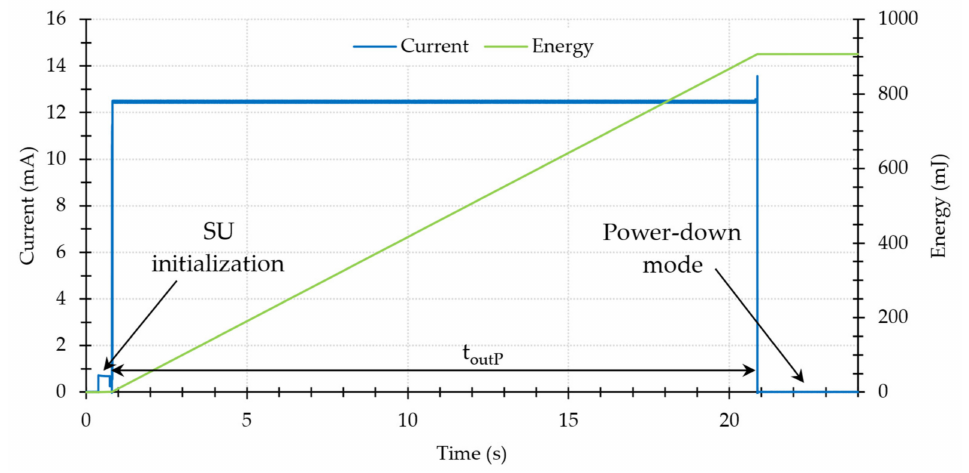
Figure 14. Instantaneous supply current and energy transfer for the SU detecting the communication error during the assembling of a system.